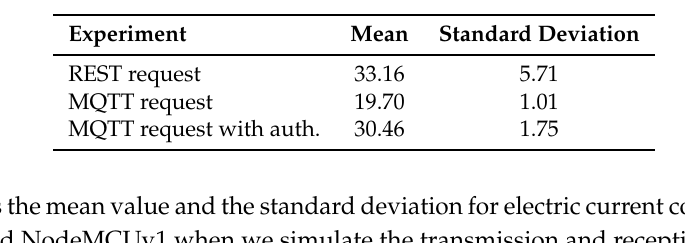
Table 4. Results in energy consumption measurement (millijoules). REST: Representational State